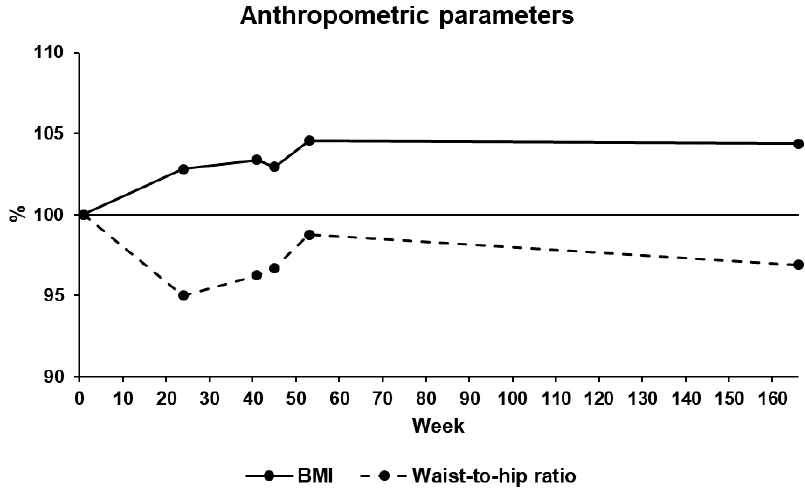
Figure 3. Evolution of anthropometric parameters during the 38-month period of the study. BMI: body mass index.